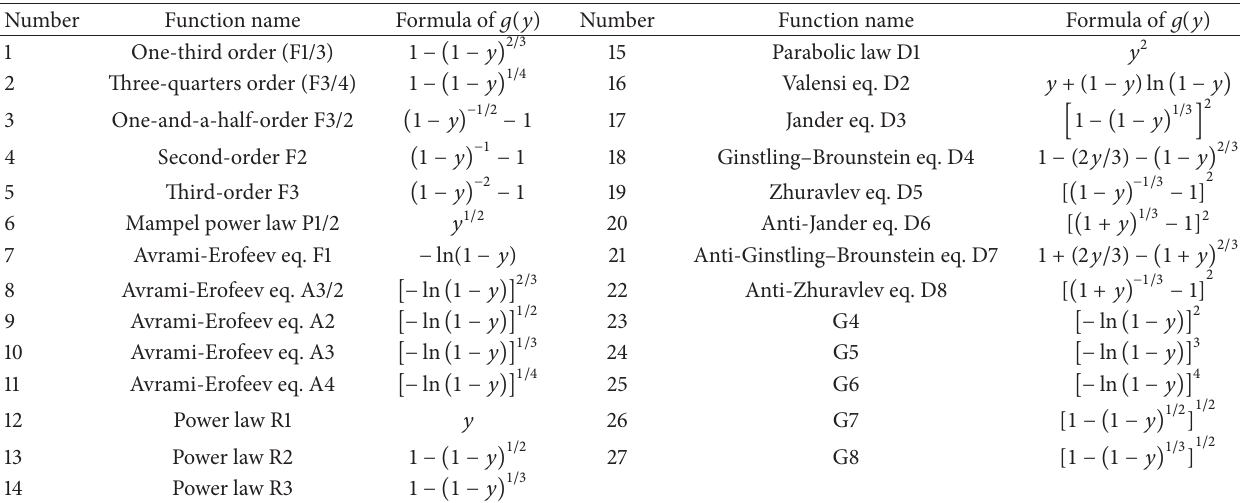
Table 2: Kinetic model functions 𝑔(𝛼) usually employed for